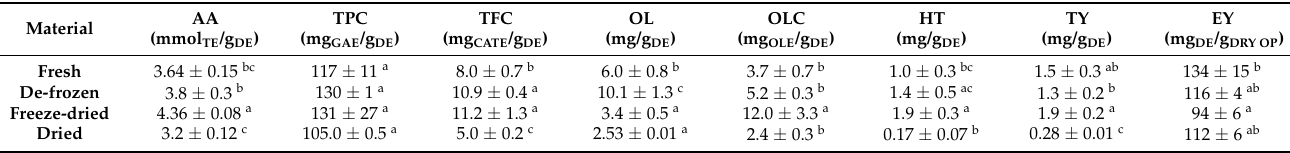
Table 1. Results obtained for extracts generated by conventional phenolic extraction conditions, using olive pomace (OP) pretreated at different conditions. Values with different lowercase letters in the same column are significantly different ( p < 0.05).